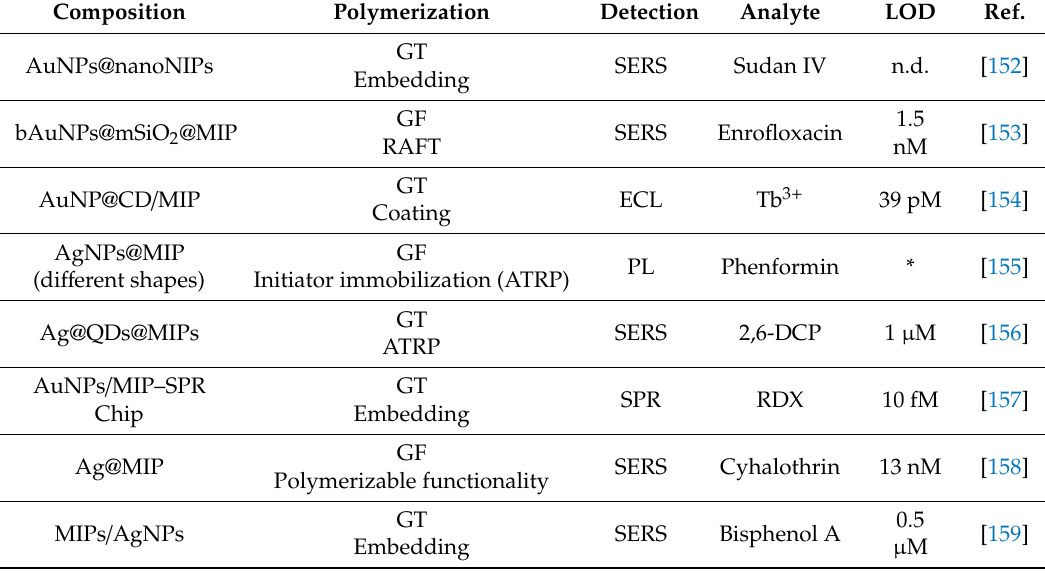
Table 8. Optical sensors based on MIPs deposited on / grown from a metal core.